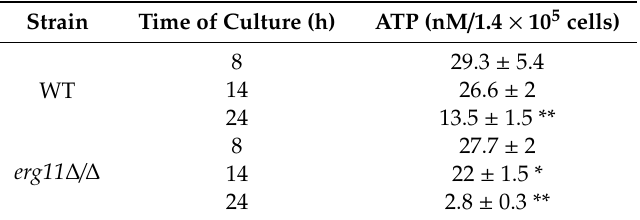
Table 3. Intracellular level of ATP [nM] per 1.4 × 10 5 cells (means ± SD, n = 6), measured by luciferase luminescence in C. albicans WT (CAF2-1) and KS028 ( erg11 ∆ / ∆ ) strains during growth (8, 14, and 24 h). Statistical analysis was performed in accordance to GP value for 8 h WT strain (*, p < 0.05; **, p <